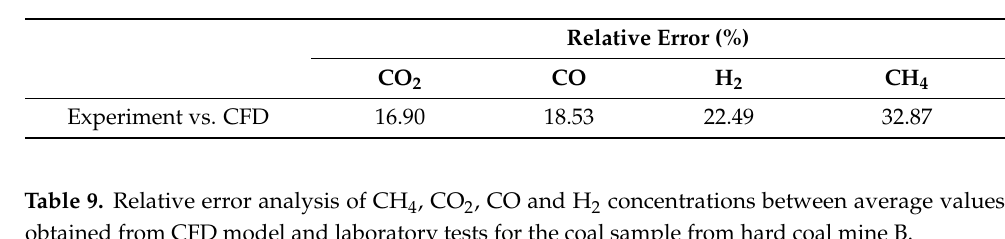
Table 8. Relative error analysis of CH 4 , CO 2 , CO and H 2 concentrations between average values obtained from the CFD model and laboratory tests for the coal sample from hard coal mine A.